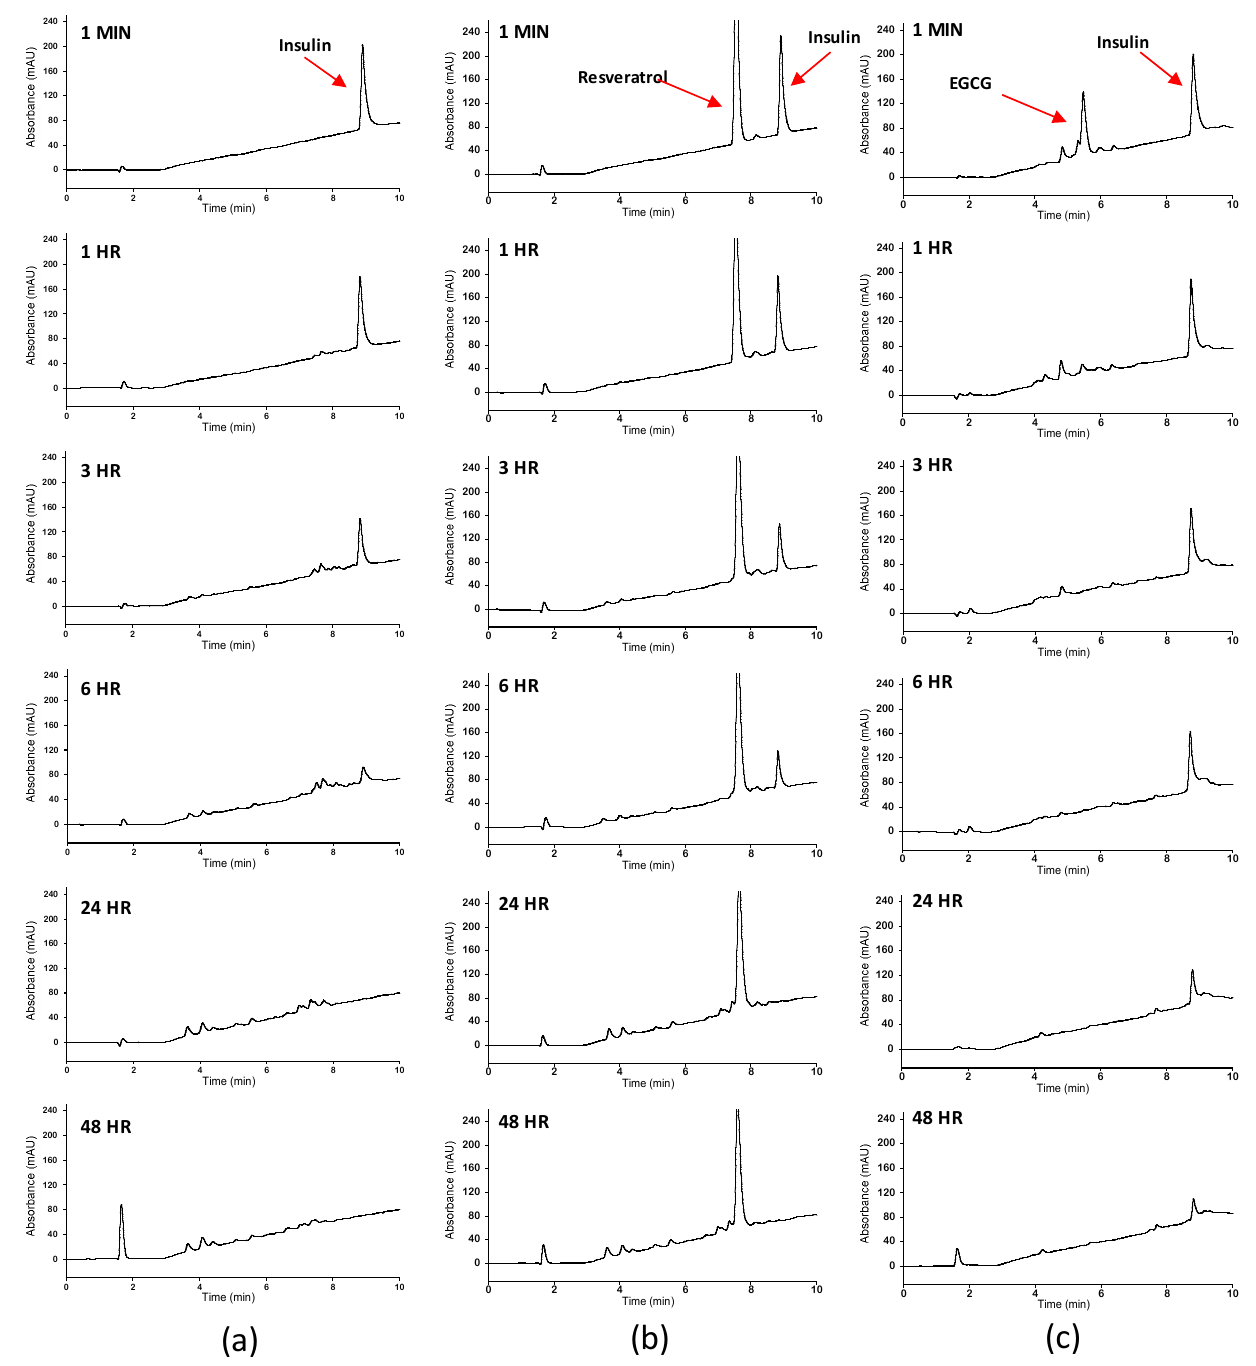
Figure 5. RP HPLC analysis of IDE-dependent degradation of insulin in the absence and presence of polyphenols at 37 °C. ( a ) Chromatograms of insulin digests in the absence of polyphenols (control samples) show the progressive loss of the insulin peak over the digestion period. This loss is accompanied by new peaks at shorter retention times due to the formation of insulin fragments. The chromatogram recorded for the 24-hr digest shows the absence of the insulin peak, indicating complete degradation of insulin. ( b ) Chromatograms of insulin digests in the presence of resveratrol are similar to the chromatograms in ( a ) with the exception of the peak for the polyphenol at a retention time of 7.5 min. Digestion of insulin is complete within 24 h. ( c ) Chromatograms of insulin digests in the presence of EGCG show that the digestion of insulin was not complete, even after 48 h of digestion. The intensity of the insulin peak, however, decreased with digestion time, suggesting that the inhibition by EGCG was partial and not complete. The intensity of the peak for EGCG decreased with incubation time presumably because of epimerization and/or dimerization.